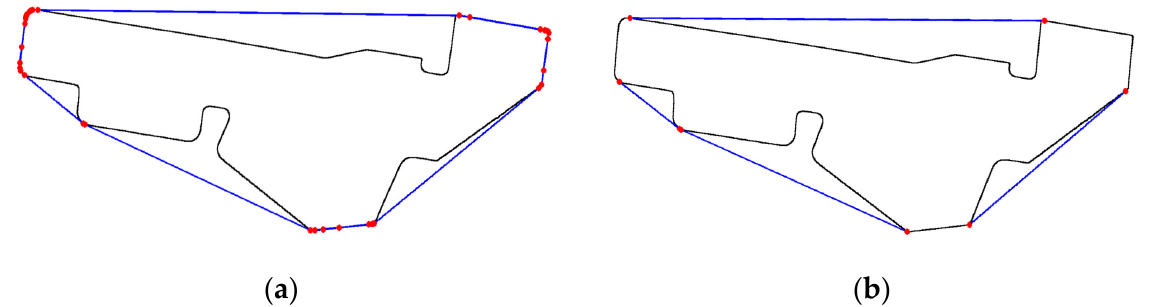
Figure 5. Method of contour segmentation: ( a ) the original convex hull and the segmentation points of the contour and ( b ) the optimized convex hull and the segmentation points of the contour. Recognition of the segmented contour segments requires the description of features. Normalized Fourier descriptors of contours exhibit invariance to translation, rotation, and scaling. Consequently, the Fourier descriptors of the contour segments can be retrieved and utilized as prominent features for segmented target recognition. Assume that a single contour segment consists of N points. The two-dimensional coordinates of the N contour points are converted to the plural as follows: